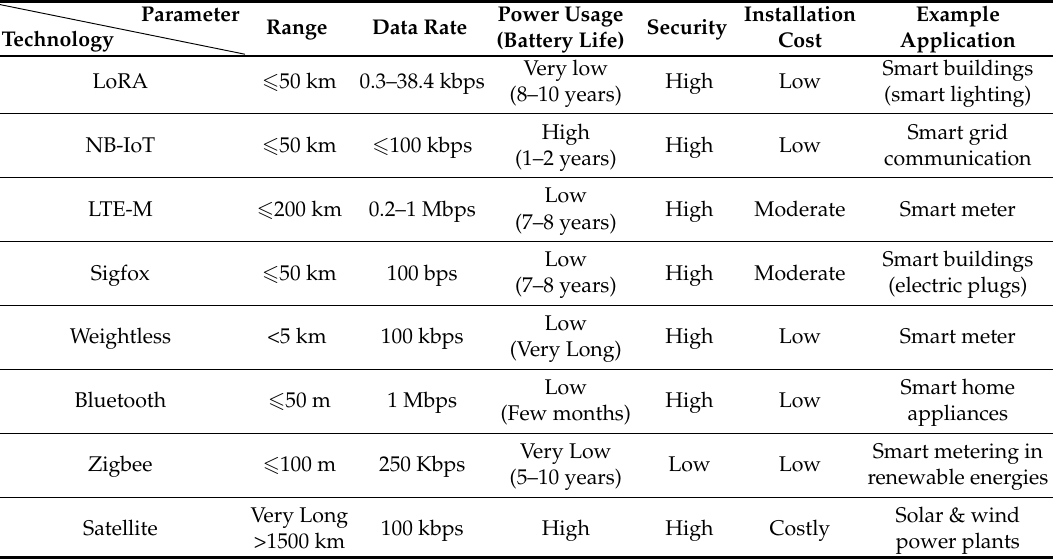
Table 1. Comparison between different wireless technologies